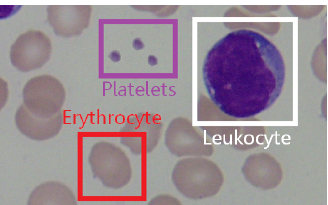
Figure 1. Blood smear components. The red rectangle presents an example of an erythrocyte; the white box shows a leukocyte; while the violet one includes some